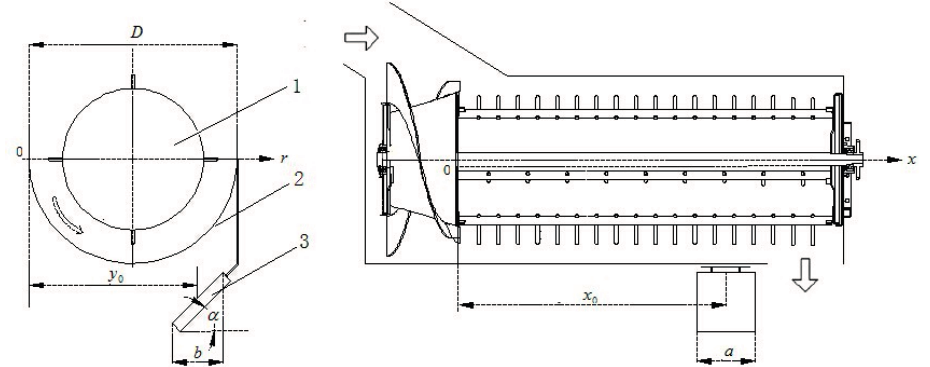
Figure 1. Diagram of grain separation losses monitoring method. 1. Separation rotor; 2. Separation concave; 3. Monitoring sensor.